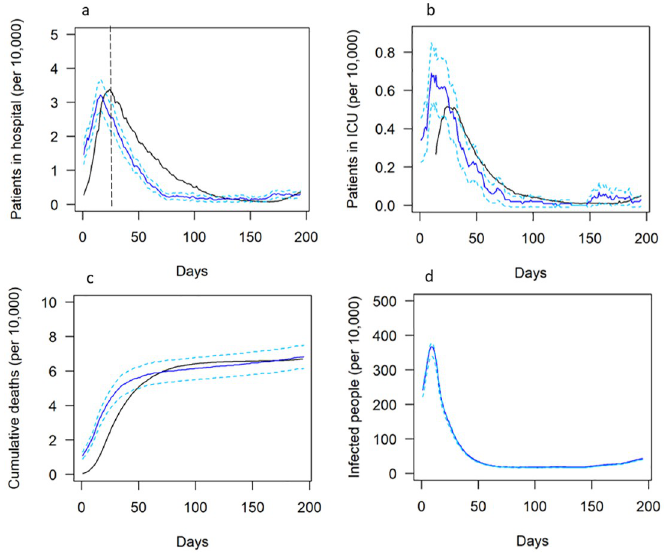
Fig 3. Validation results. Observed (black) and modelled (blue) data for patients in hospital (a), patients in ICU (b) and cumulative deaths (c) per 10,000 people between 20th March and 30th September 2020. Modelled data for number of infections (d) is also shown for reference. Dashed blue lines represent 95% confidence intervals and the data before the dashed black line (a) represents calibration data.